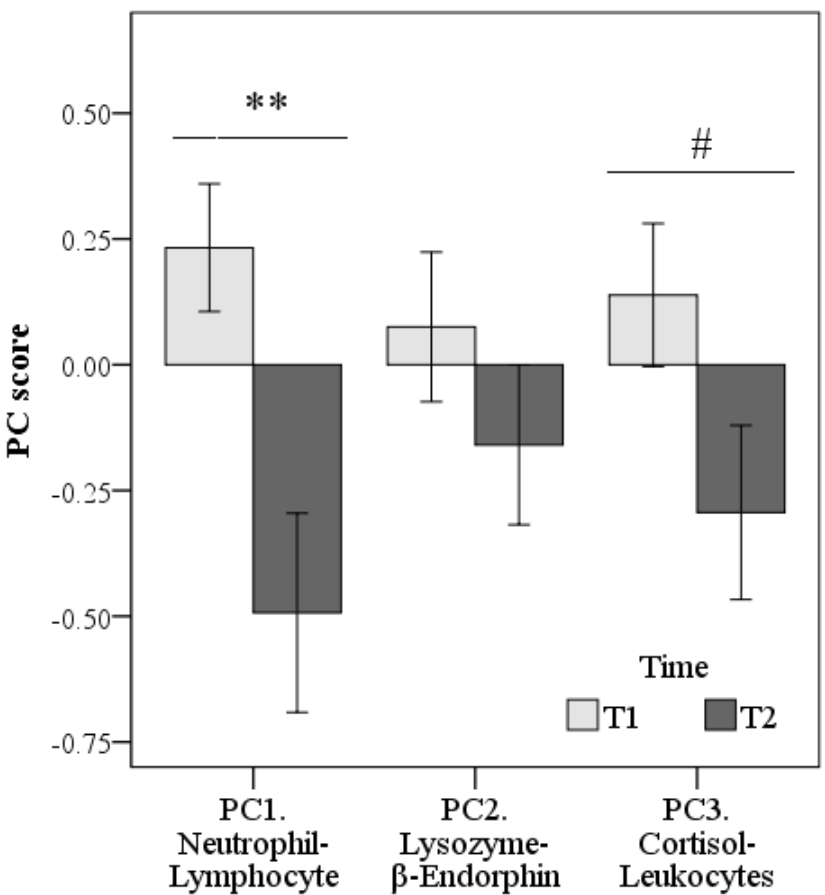
Figure 3. Di ff erences in scores of PC1. Neutrophil-Lymphocyte, PC2.Lysozyme- β -Endorphin, and PC3.Cortisol-Leukocytes between the first (three days of shelter intake, Time 1 = T1) and the second sampling (after four weeks of acclimation in the shelter, Time 2 = T2). ** p < 0.01, # p <